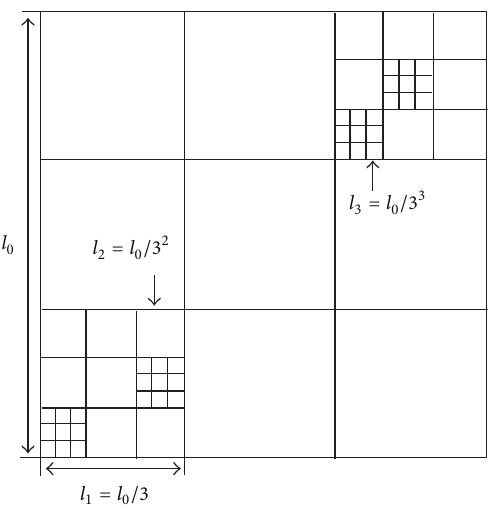
Figure 1: A two-dimensional projection of the fragmentation model. Note that at a given iteration all the fragments have the same size. The probability that the cube with edge length 𝑙 0 ( 𝑚 = 0; initiator) will be fragmented into 27 cubes of edge length 𝑙 1 is 𝑓 .